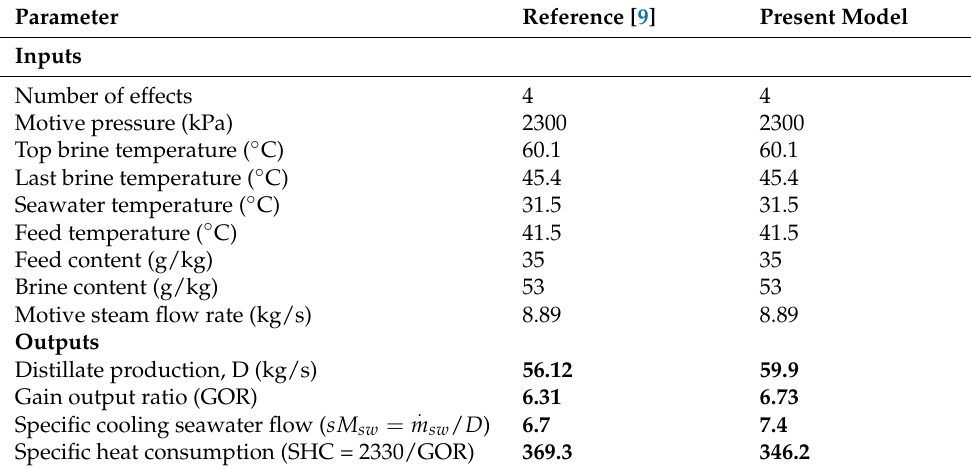
Table 2. Validation results of MED-TVC model.